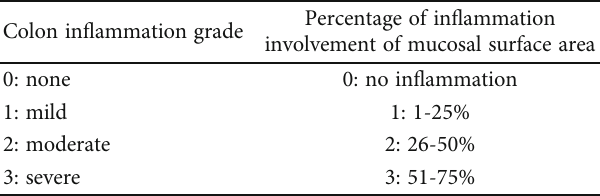
Table 2: Determination of colon in fl ammation score. Colon in fl ammation